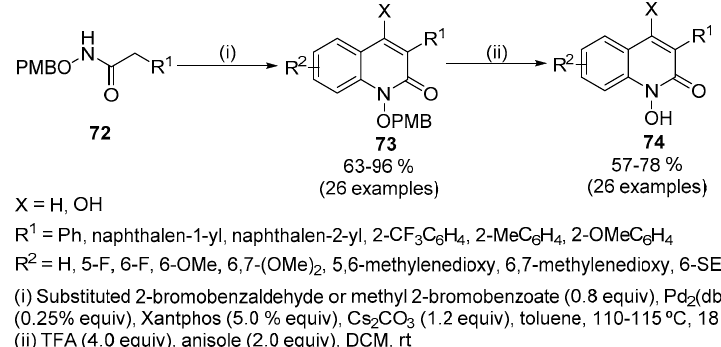
Scheme 22. Synthesis of N -hydroxyquinolin-2(1 H )-ones 74 by Pd-catalysed Buchwald-Hartwig reaction of protected N -hydroxyamides 72 with benzaldehydes or benzoates followed by cyclodehydration and deprotection [42].